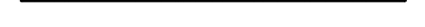
FIG. 9. Figure for friction post-test problem 6.